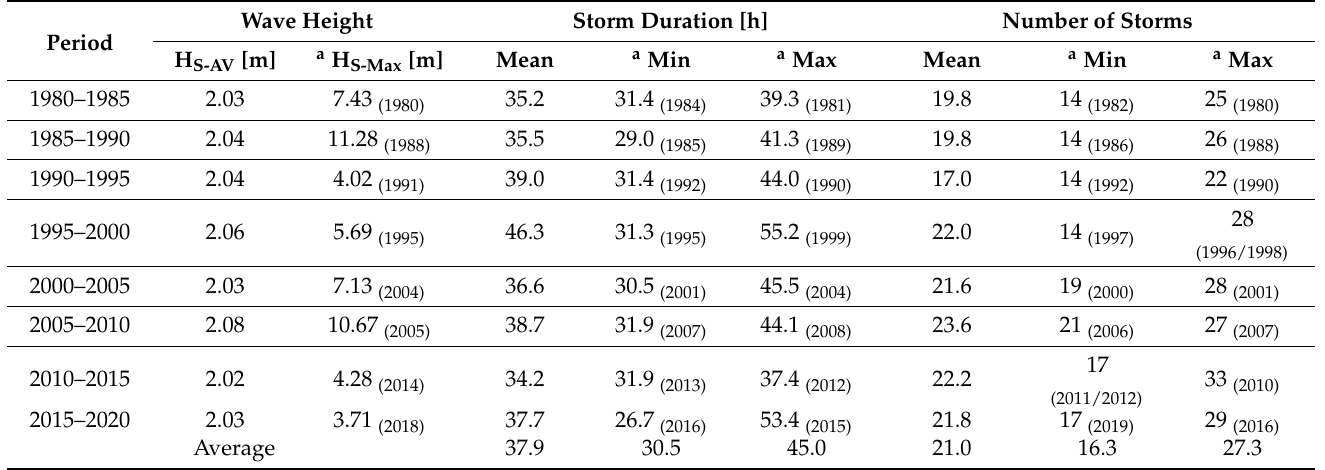
Table 2. Mean and maximum wave height during extreme wave conditions, storm duration and number of storms for every five-year